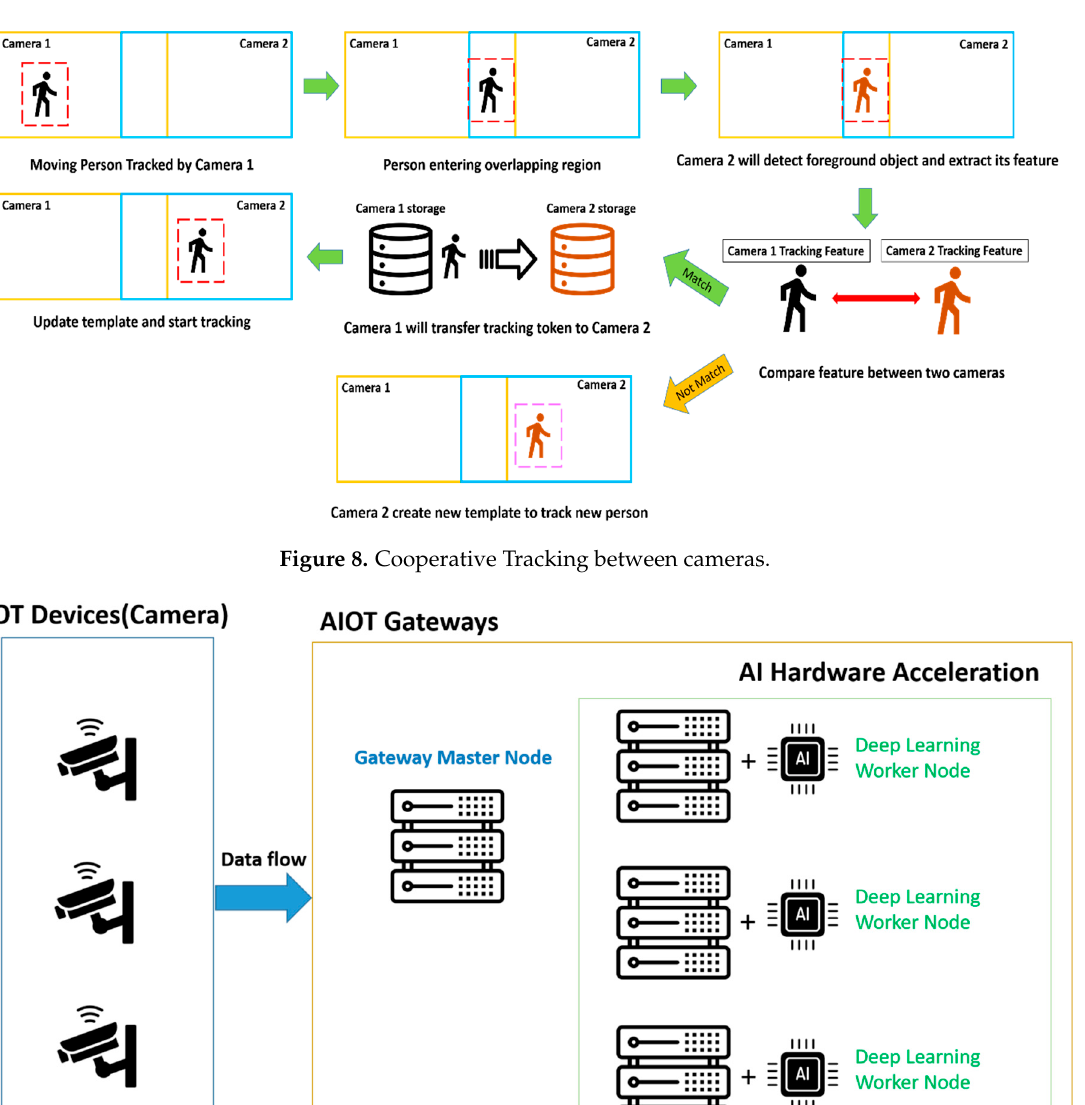
Figure 9. Structure of the system.